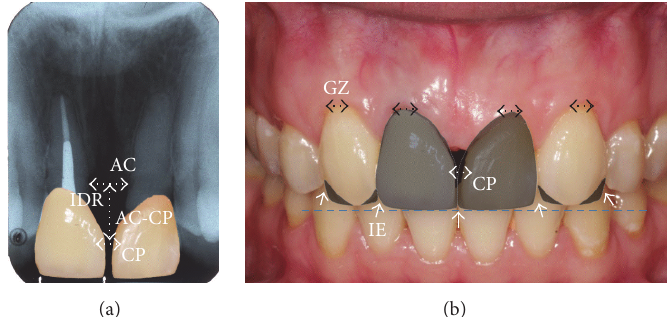
Figure2:Analysisof“pink”and“white”estheticsandtherestorativeplan.(a)Radiographicanalysis.IDR,theinterproximaldistancebetween roots; AC-CP,the distance between themost coronal part of thealveolar bone crest (AC) and themost apical part of the contact point (CP). (b) Clinical photograph analysis. Gingival zenith (GZ) positions, level of upper incisal edge (blue line), incisal edge embrasure (IE), and deficient interdental papilla (black triangle between two teeth) after placement of adhesive restorations are shown. Hyaluronic acid filler injection is planned to fill the deficient interdental papilla.